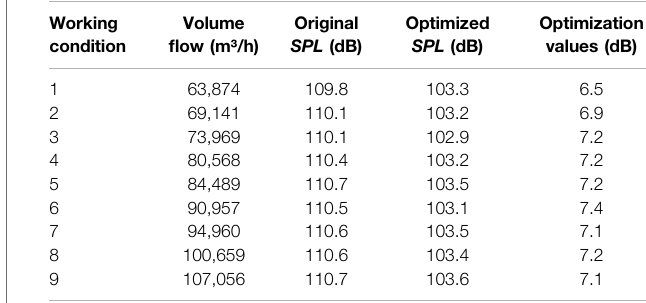
TABLE 4 | Experimental the noise value under each working